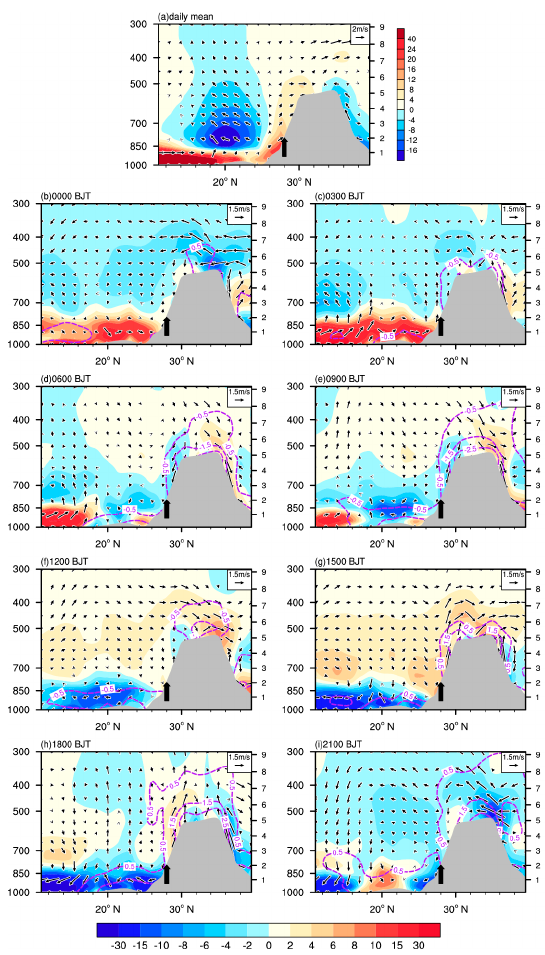
Figure 5. The latitude − height cross-sections of the meridional water vapor transport (shaded; unit: g kg − 1 m s − 1 ) and vertical circulation in summer (vectors; unit: m s − 1 ; the omega has been multiplied by − 10, unit: Pa s − 1 ) along 81° − 85° E. ( a ) is the daily mean; ( b − i ) are the diurnal deviations at 3 h intervals with the daily mean removed. Purple dashed contours denote temperature deviations (units °C). The gray shaded areas represent the topography. The black upward arrows above the topography indicate the southern boundary of the TP (elevation greater than 2000 m).